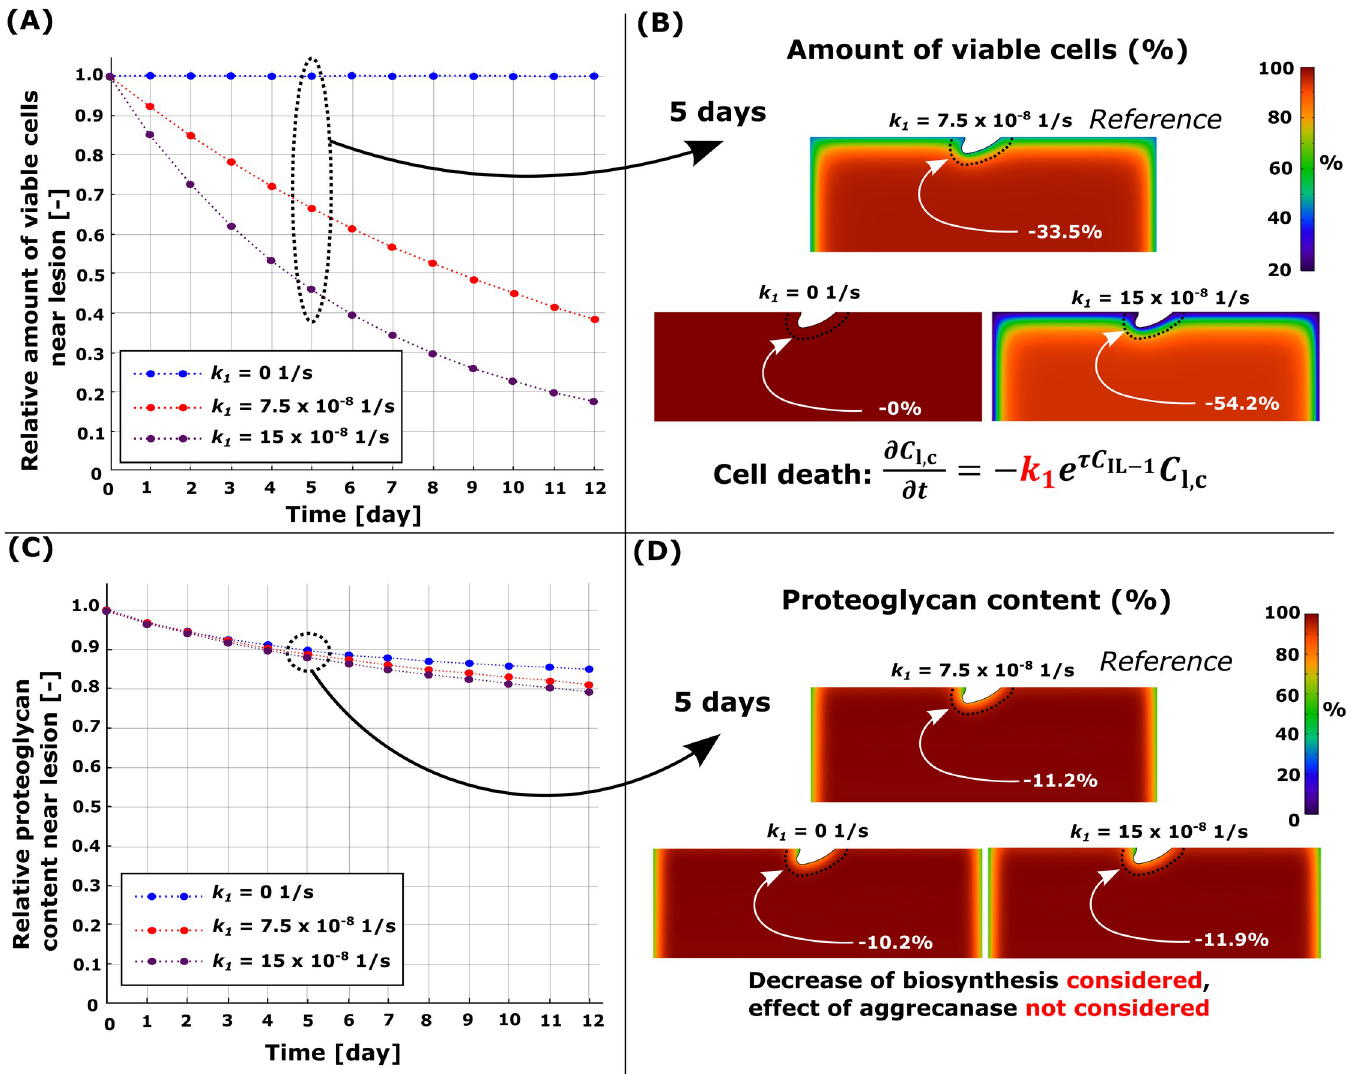
Fig 7. Sensitivity analysis for the simulated pro-inflammatory cytokine-induced apoptosis rate k 1 . Comparison of temporal and spatial changes at day 5 (A)-(B) in cell viability and (C)-(D) in proteoglycan (PG) content. (A) Loss of viable cells and, thus, a decrease of PG biosynthesis (aggrecanase-induced PG degeneration was not considered), had (C) a negligible effect on the simulated PG content over 12 days. Red line in (A) and (B) refers to the reference model ( k 1 = 7 : 5 � 10 (cid:0) 8 1